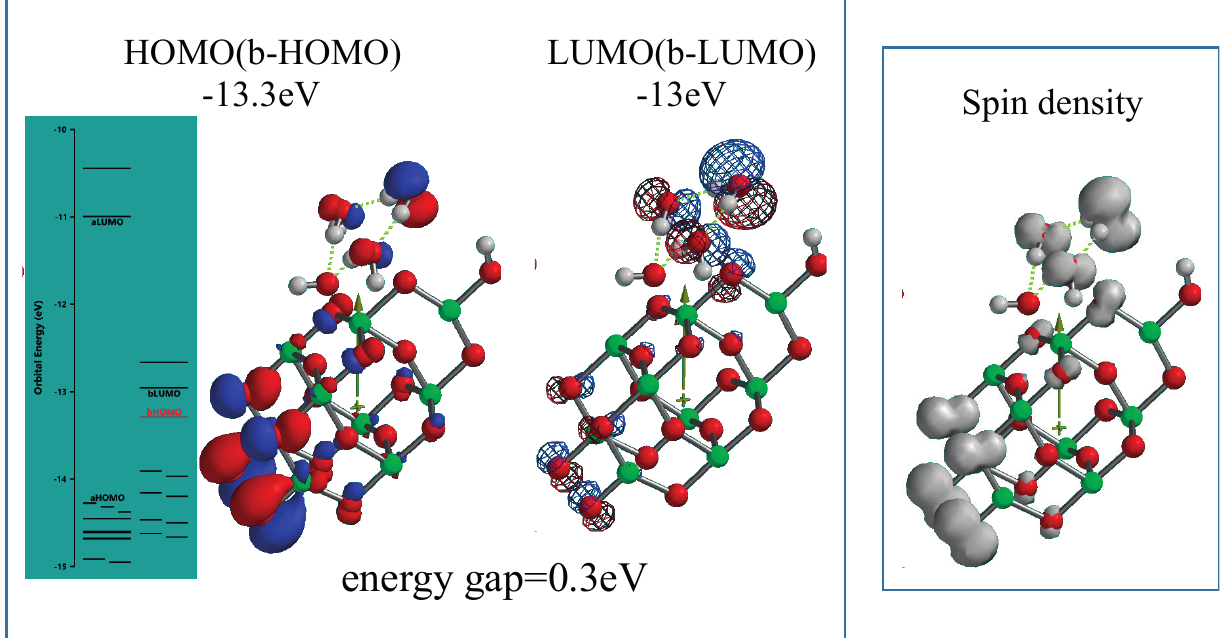
Figure 6. Energy structures of [(H 2 O) 3 ]&OH(TiO 2 ) 9 H] ..++ as the model of two